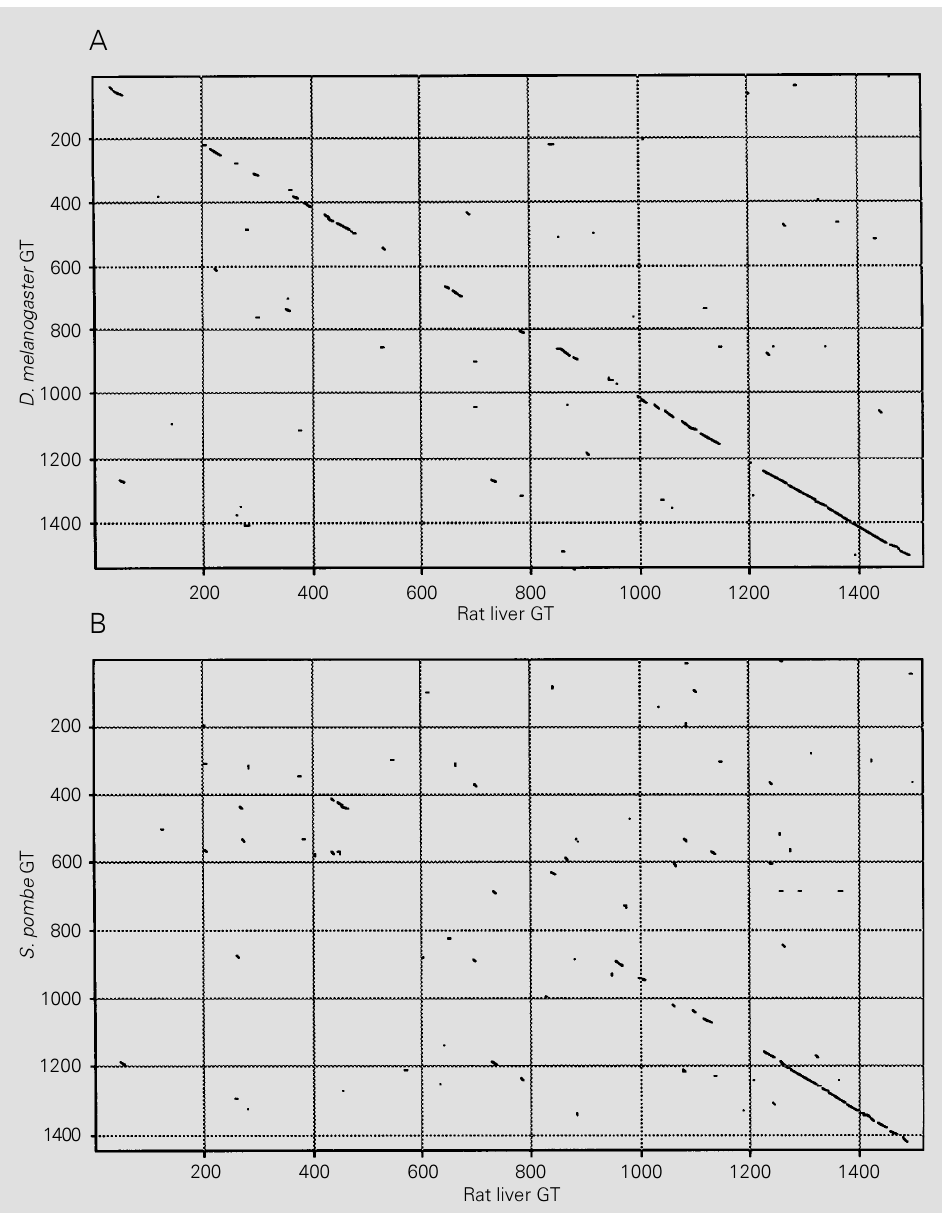
Figure 3 - Homologies between GT primary sequences of D. melanogaster (A) and S. pombe (B) with that of the rat liver en- zyme (window size: 8; min% score: 60; hash value: